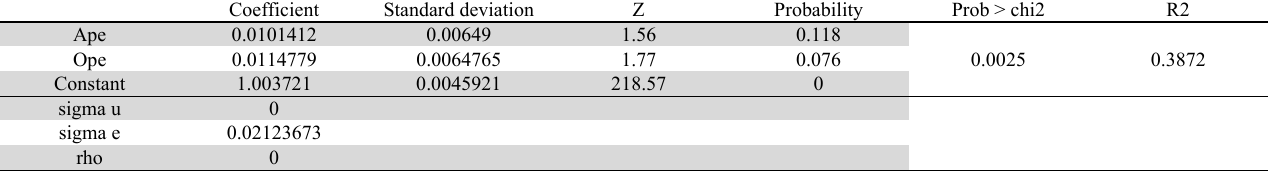
Regression analysis (random-effects) for non-metallic mining companies